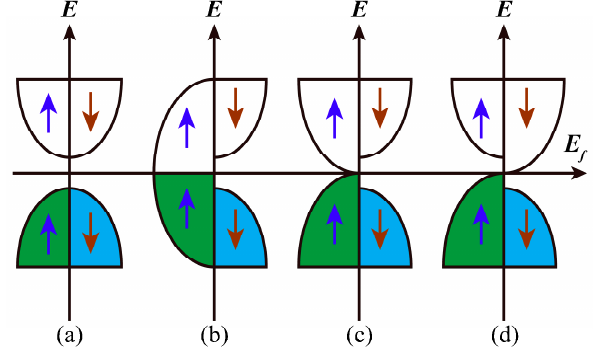
Figure 1. Schematic density of states of ( a ) semiconductor, ( b ) half-metal, and ( c , d ) spin gapless semiconductor. “ ↑ ” and “ ↓ ” indicate spin-up and spin-down channel, respectively.